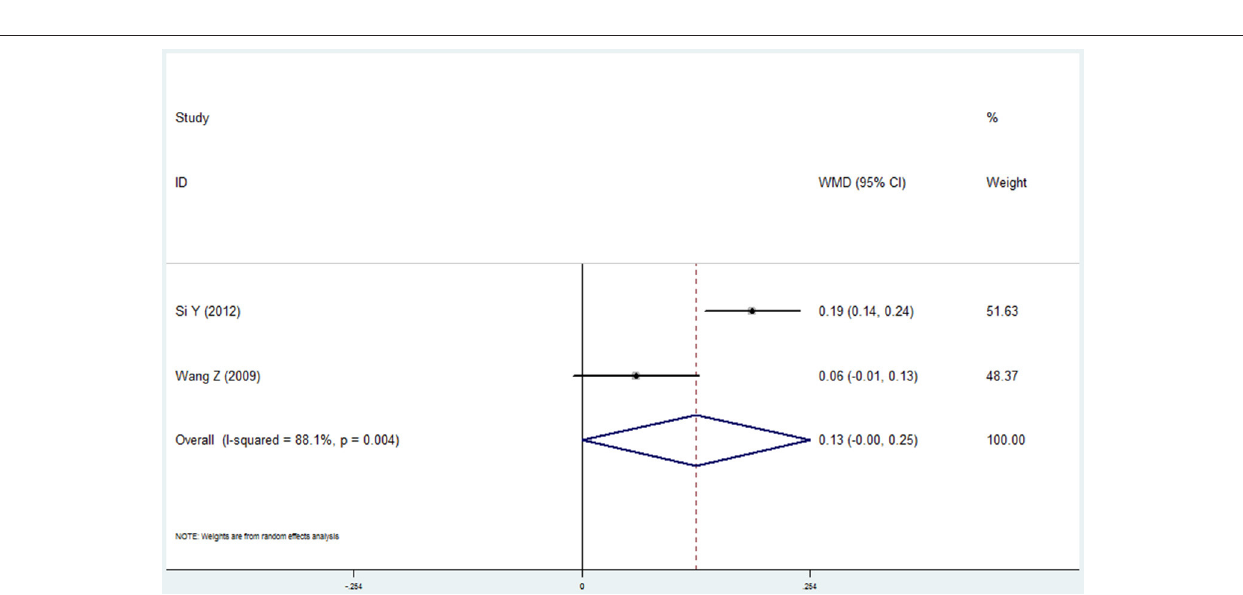
FIGURE 3 | Forest plot of the mean difference in clinical attachment loss between the COPD and non-COPD groups.